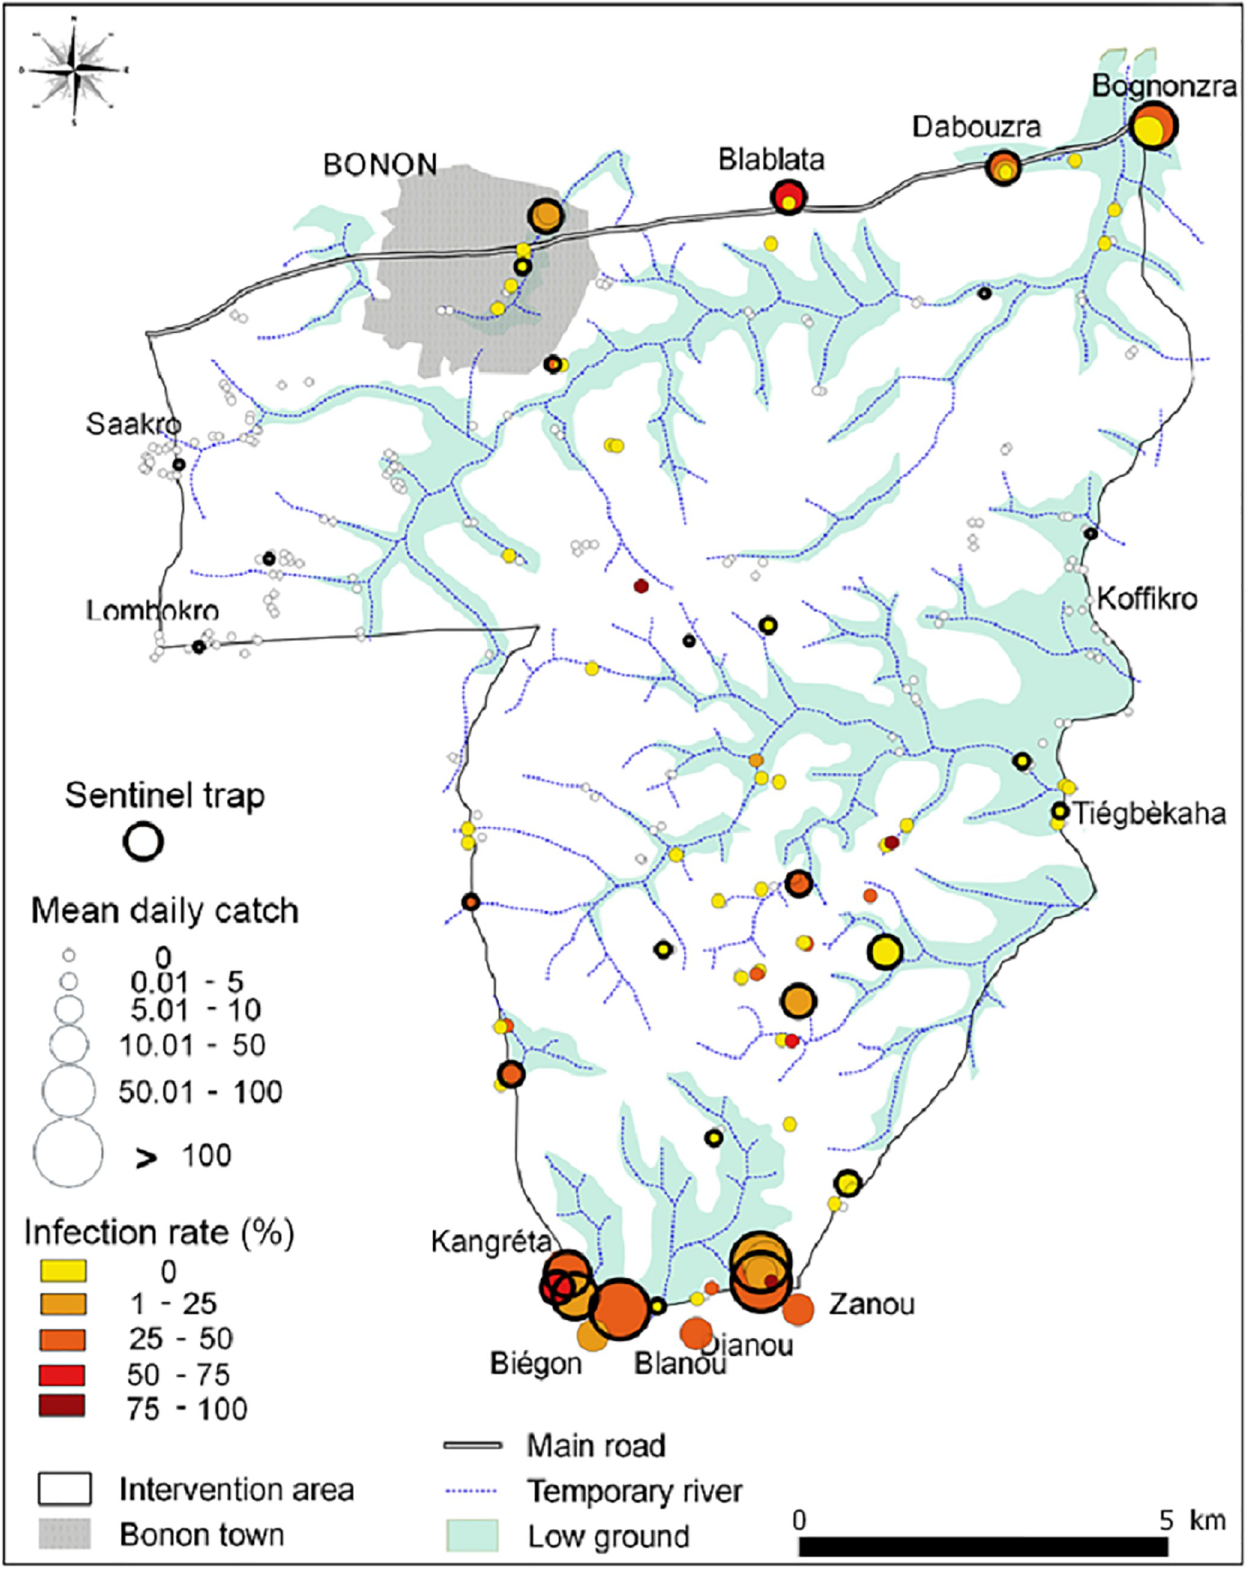
Fig 3. Tsetse densities and infections of the T0 baseline entomological survey. https://doi.org/10.1371/journal.pntd.0009404.g003 PLOS NeglectedTropical Diseases | https://doi.org/10.1371/journal.pntd.0009404 June 28,